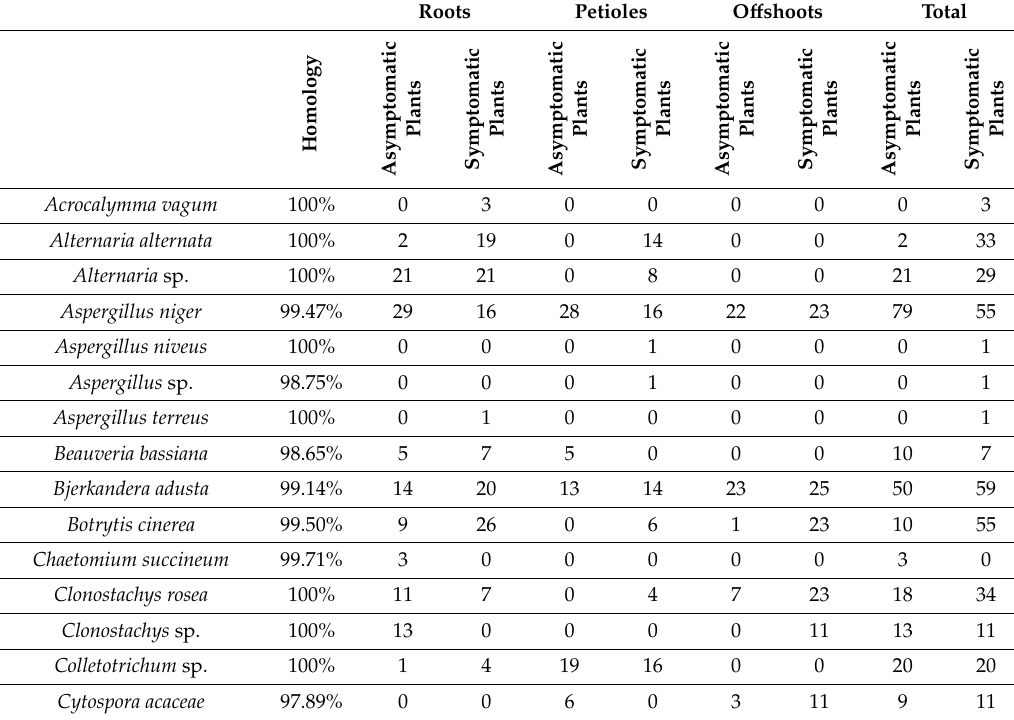
Table 1. Fungi identified morphologically and molecularly through ITS region, collected in vineyards located in the Alentejo region. The percentage of sequence homology explored at the NCBI database using the BLAST algorithm and the respective number of isolates according to symptomatology and plant organs are